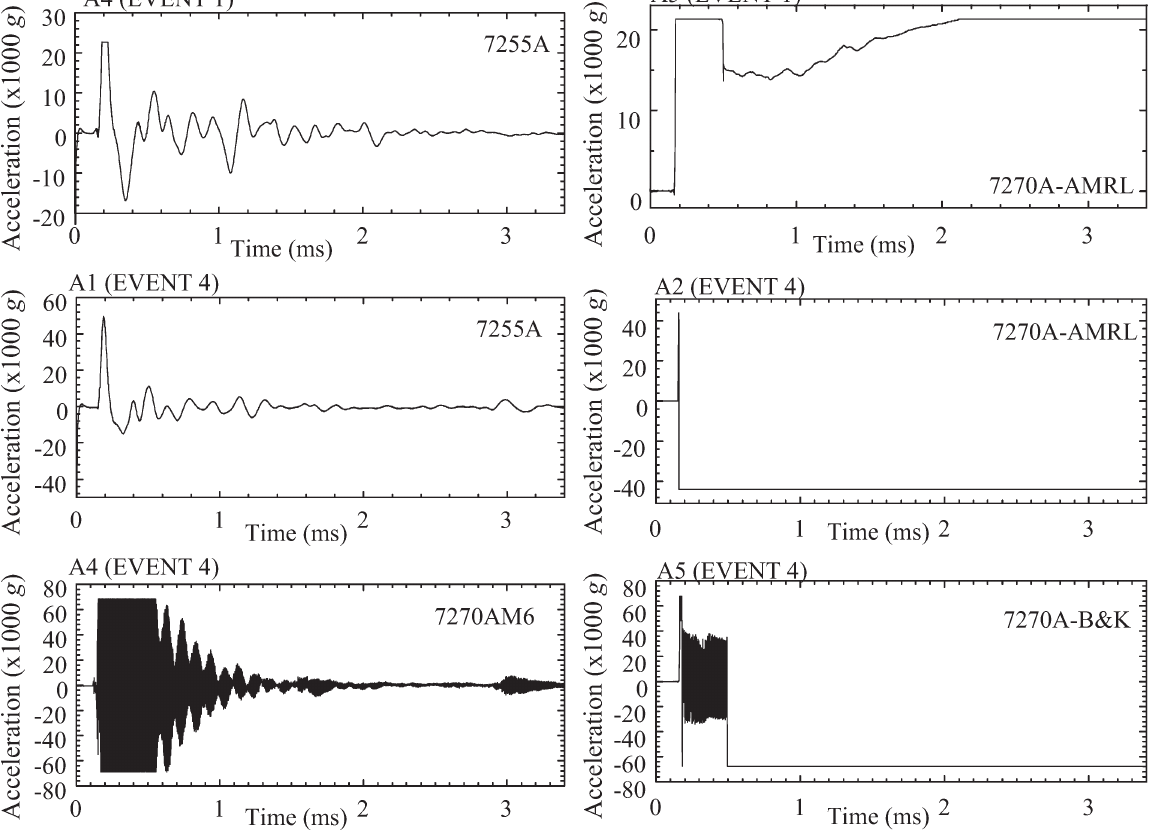
Fig. 11. Acceleration results for locations A1, A2, A4 and A5. The charge consisted of 10 g of PE4 located at 15 cm from location A3, that is the transducers were located 25 cm from the